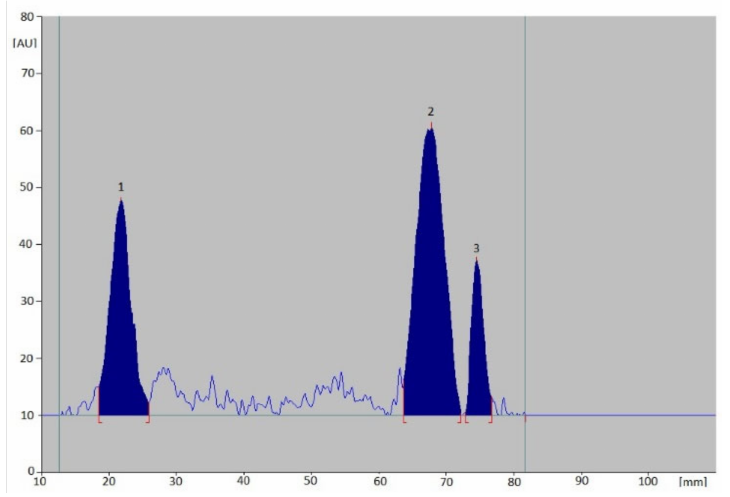
Figure 3. An example densitogram obtained for the standard solutions of the analyzed vitamins (1—K 2 , 2—D 3 , 3—D 2